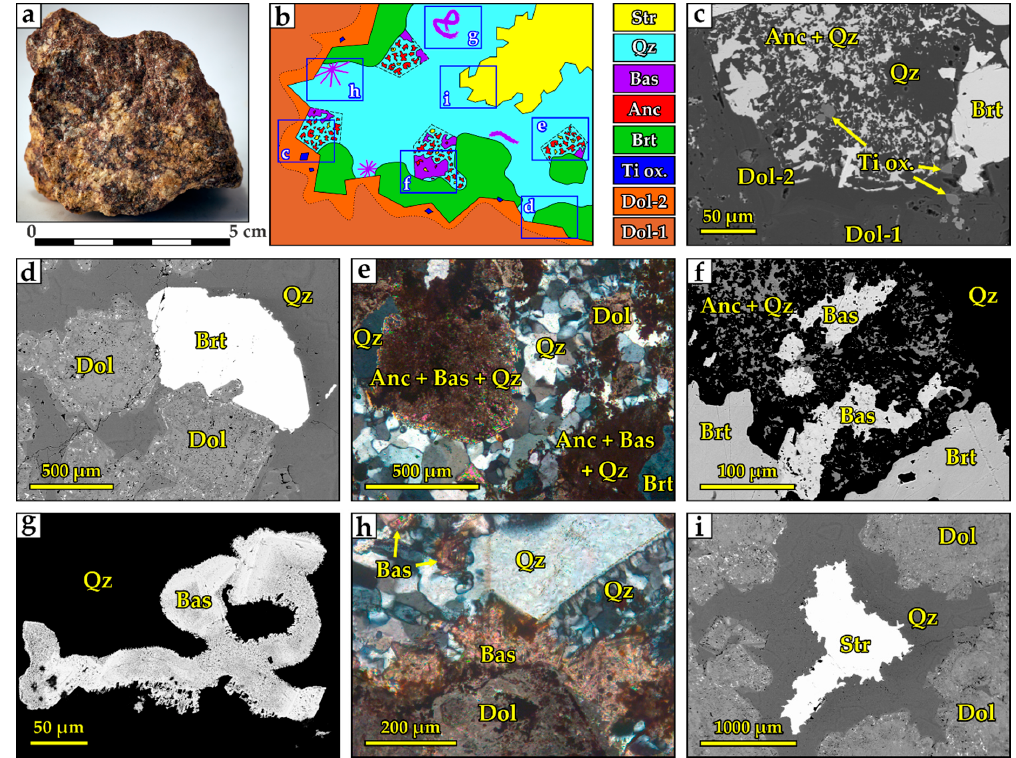
Figure 15. ( a ) A sample of “hybrid” carbonatite. ( b ) A sketch comprising the typical location of the mineral assemblages in the rock texture ( c ) to ( i ). ( c ) Ti-oxides in Dol-2. ( d ) Baryte overgrowing dolomite. ( e ) Pseudomorphically replaced ancylite. ( f ) Anatomy of pseudomorphs after ancylite. ( g ) Spongy bastnäsite. ( h ) A cluster of bastnäsite needles. ( i ) A cavity in quartz filled with strontianite. Photomicrographs ( e , f ) in transmitted cross-polarized light; all others—BSE images.